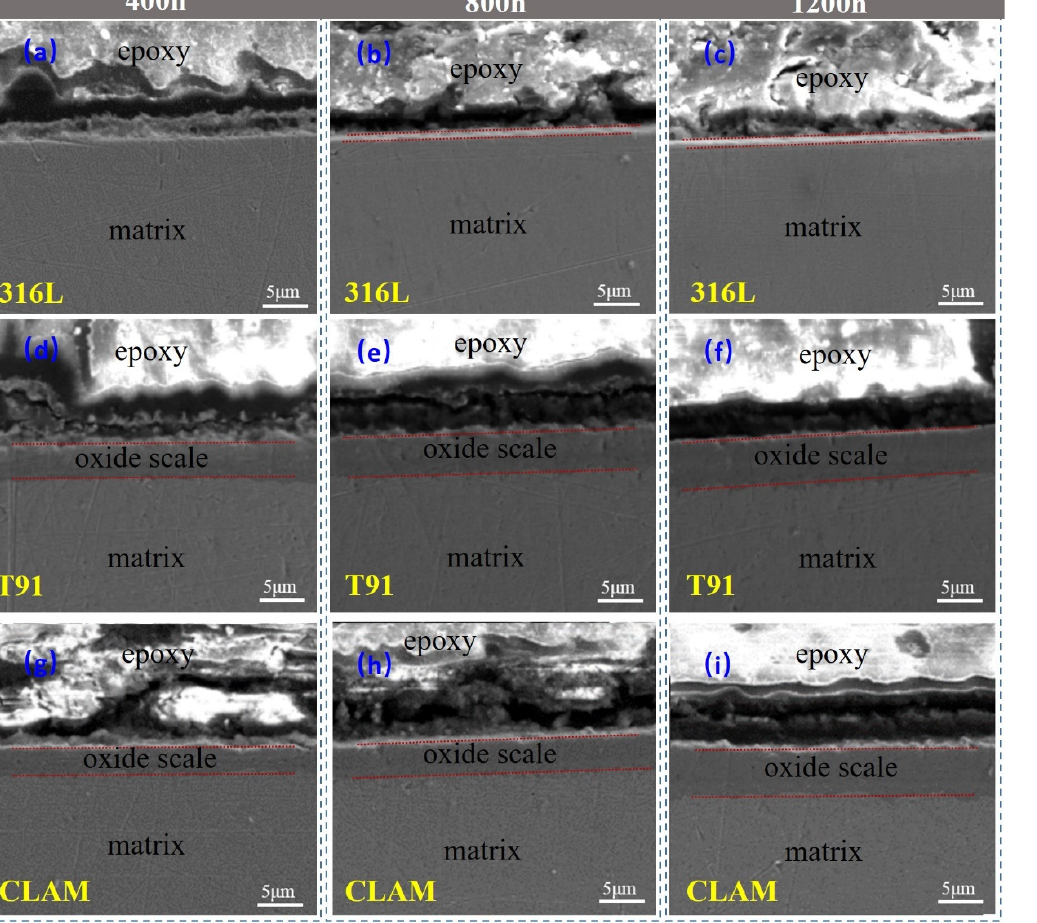
Figure 6. Cross-section morphology of the corroded samples: ( a ) 316L-400h, ( b ) 316L-800h, ( c ) 316L- 1200h, ( d ) T91-400h, ( e ) T91-800h, ( f ) T91-1200h, ( g ) CLAM-400h, ( h ) CLAM-800h, ( i ) CLAM-1200h.